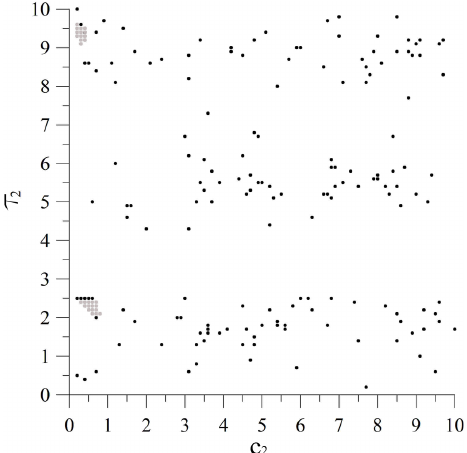
Fig. 8. Parameter domains ( τ 2 ,c 2 ) admitting equilibrium state (grey dots), periodic motion (black dots) and quasiperiodic motion (white area), for the fixed parameters c 1 = 0.2, τ 1 = 0.5. The latter values would warrant oscillatory motion for the first block in the uncoupled case. The diagram is constructed for the step size 0.1 for both c 2 and τ 2 . The remaining parameters are the same as in Fig.